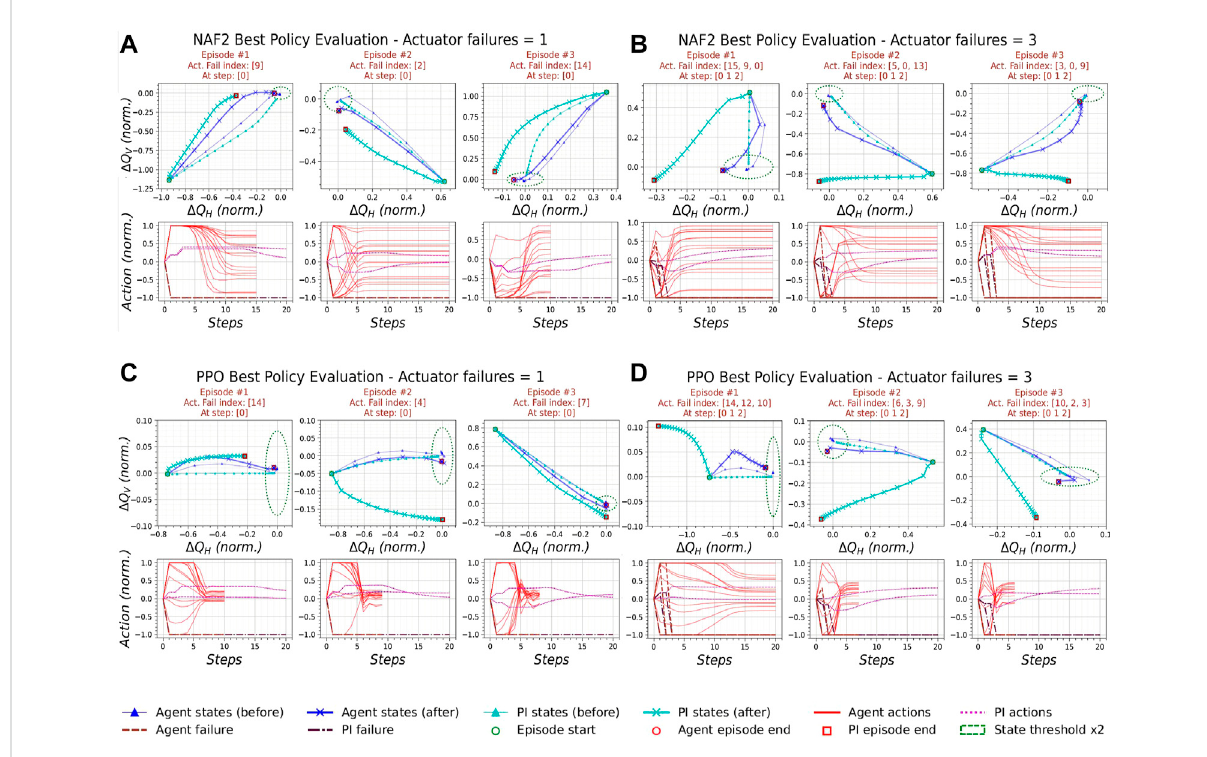
FIGURE 9 EpisodesfromthebestRLagentsandthePIcontrollerundertheeffectofdifferentnumberofactuatorfailures. (A) NAF2agentwithoneactuator failure, (B) NAF2 with three actuator failures, (C) PPO agent with one actuator failure, (D) PPO agent with three actuator